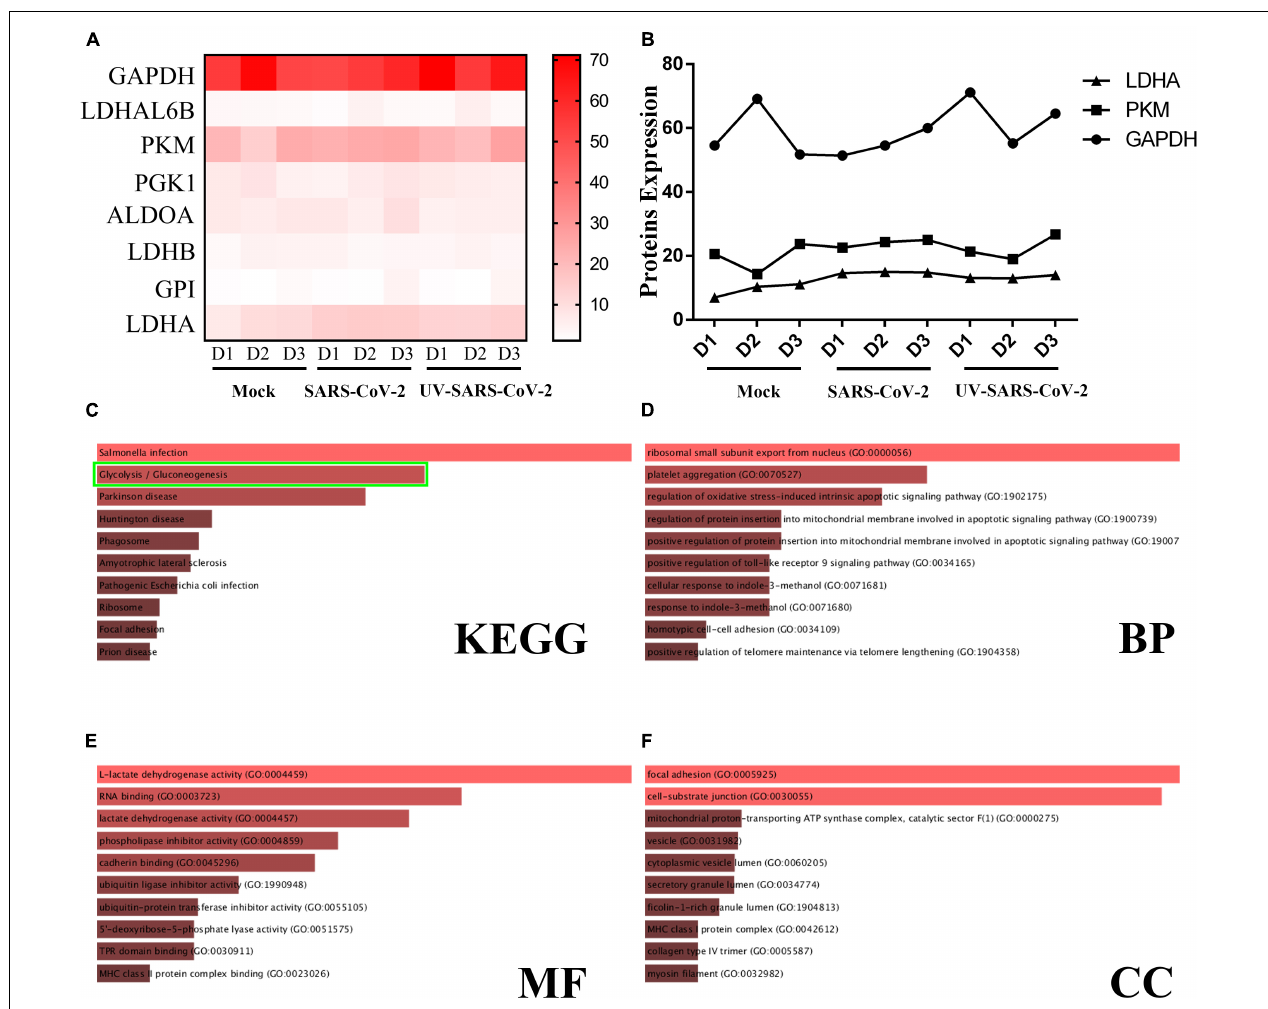
FIGURE 3 | SARS-CoV-2 infection upregulates the glycolysis pathway. (A) A heatmap was generated from the SARS-CoV-2 infection and UV-inactivated SARS-CoV-2 treatment. In both groups, LDHA level was increased. (B) The expression of LDHA, PKM, and GAPDH was significantly different among the healthy population, SARS-CoV-2, and UV-SARS-CoV-2 groups. (C) The KEGG analysis revealed the SARS-CoV-2 infection and protein correlation involved in the glycolysis pathway (the green bounding box). (D–F) The BP, MF, CC analysis revealed the SARS-CoV-2 infection involved in the oxidative stress, the lactate dehydrogenase activity, et